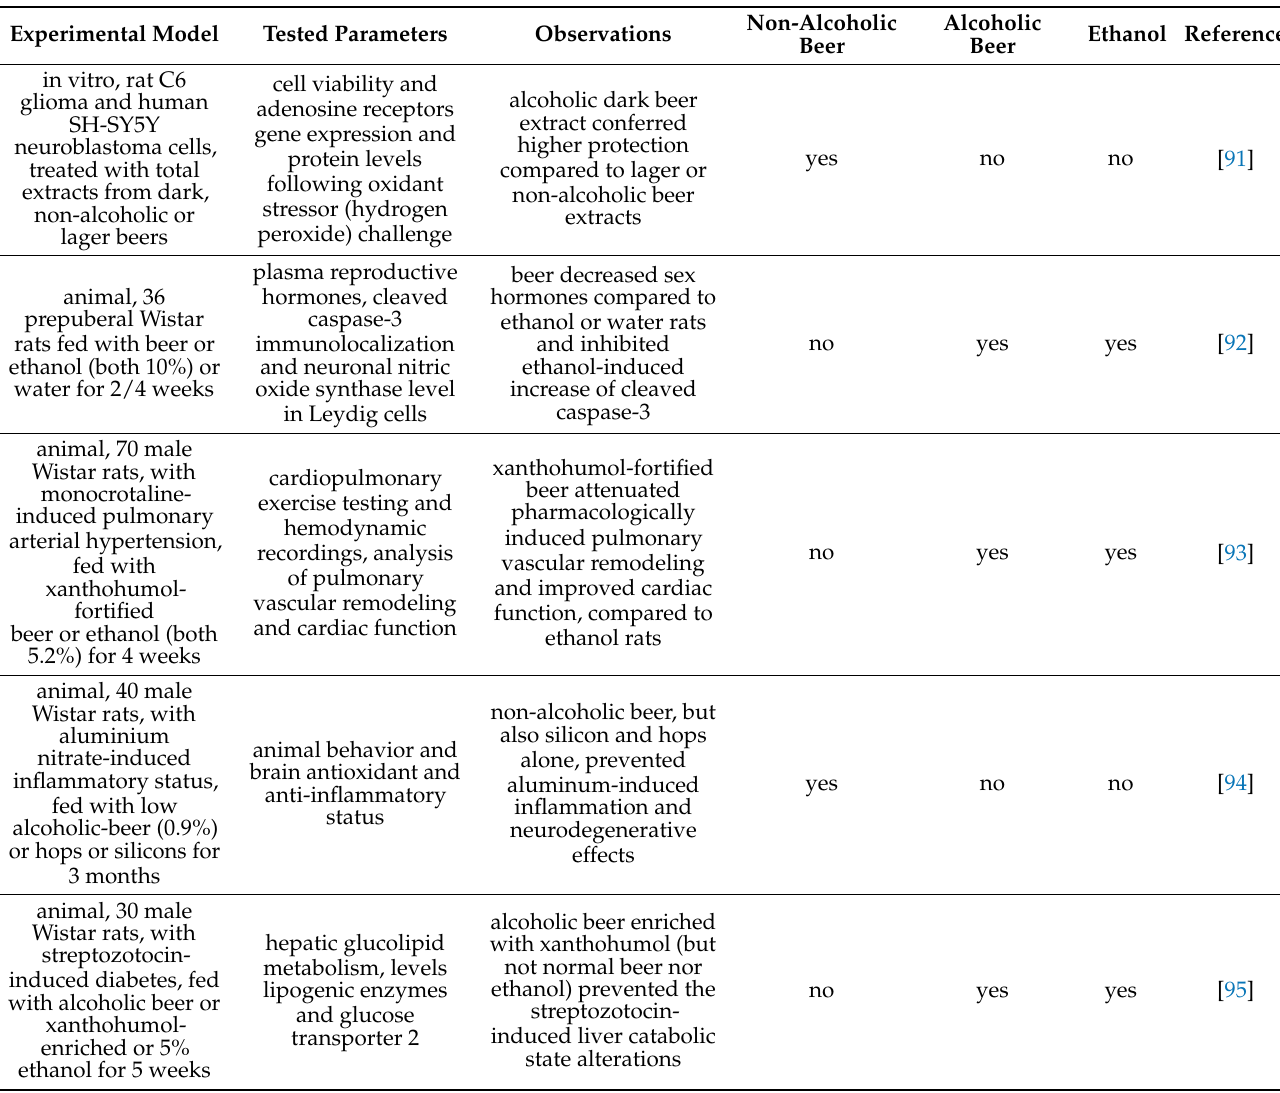
Table 1. In vitro and animal